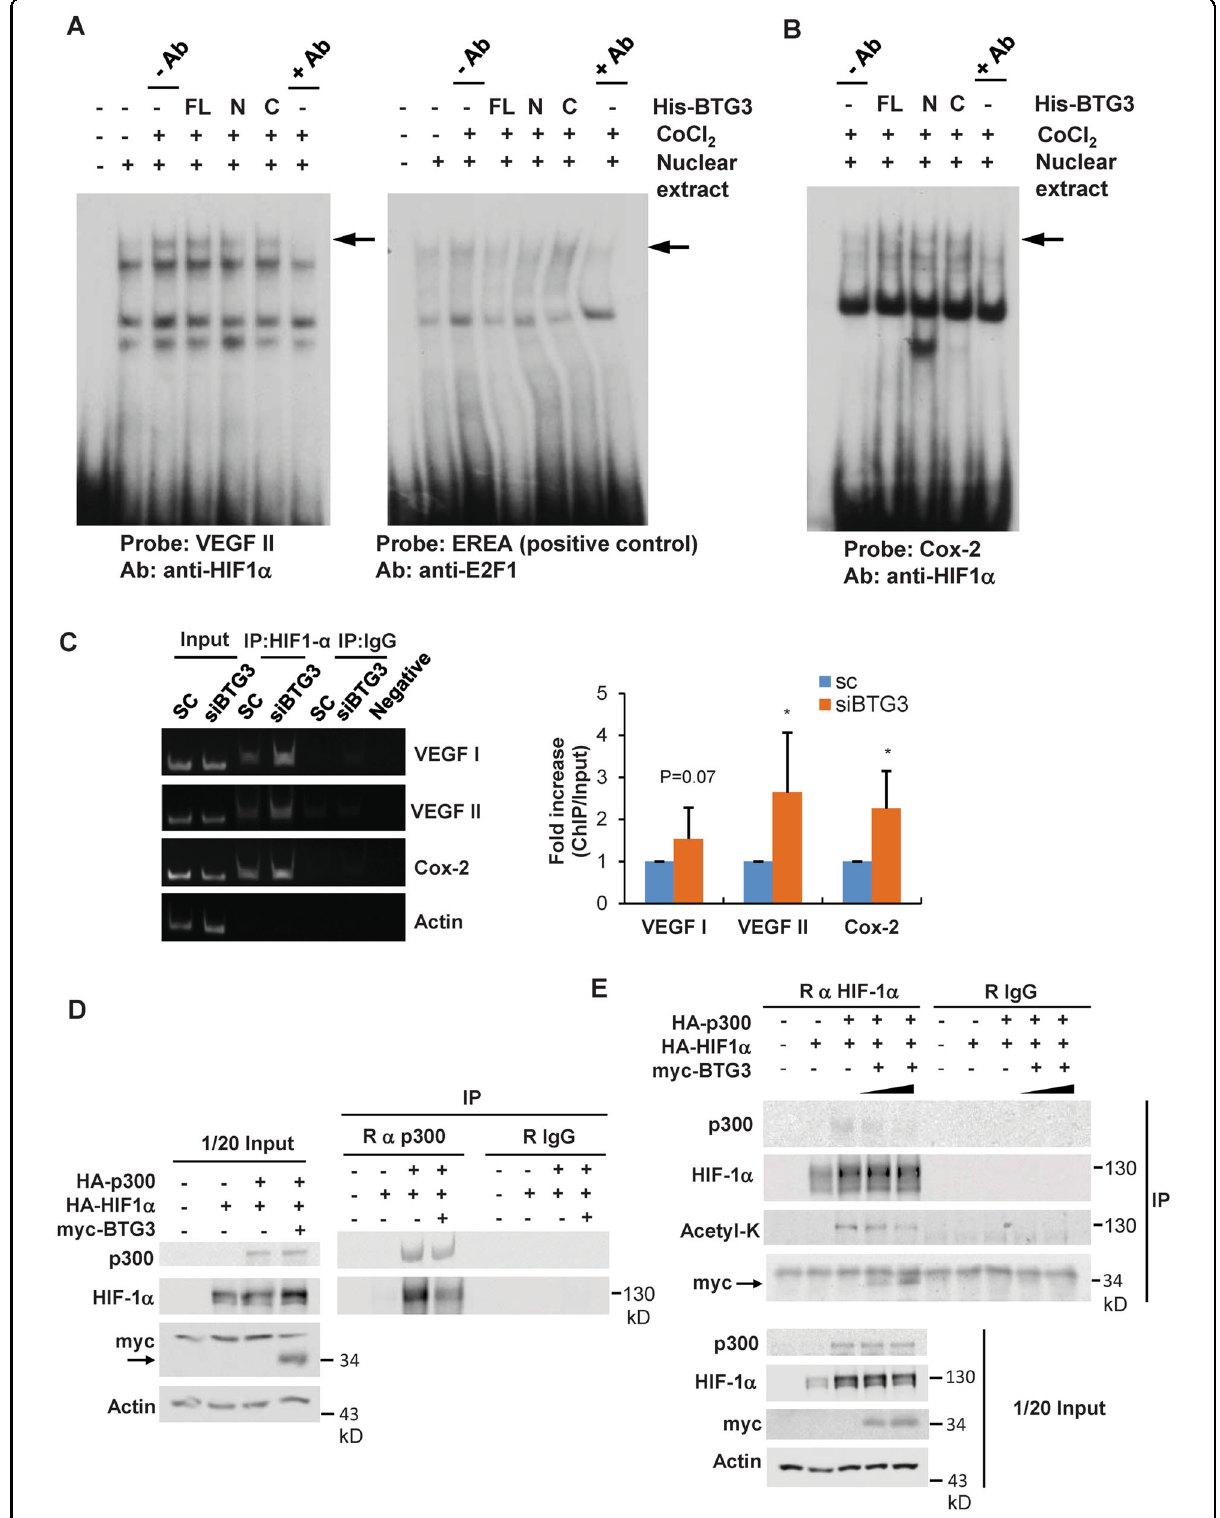
Fig. 4 (See legend on next